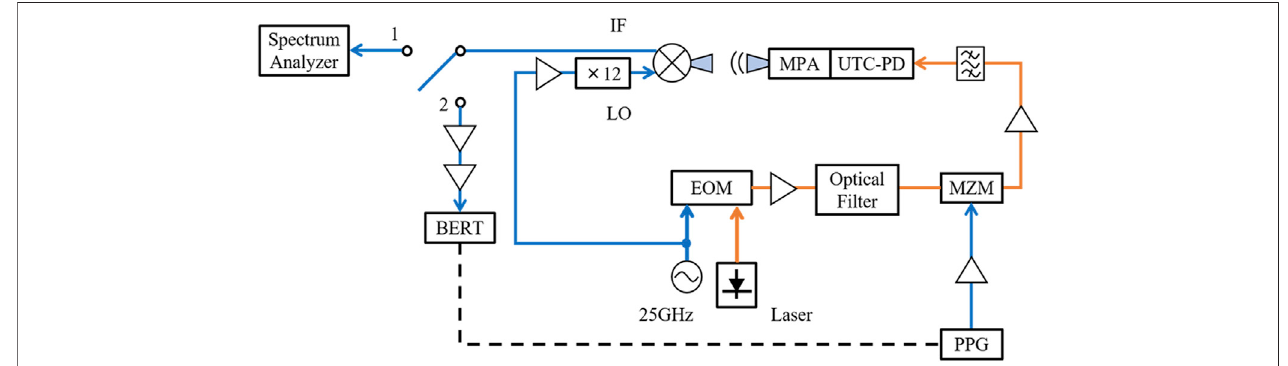
FIGURE 6 | Experimental setup for the transmission experiment. EOM: electro-optic modulator, MZM, Mach – Zehnder modulator; UTC-PD, unitraveling -carrier photodiode; MPA, medium-power ampli fi er; BERT, bit-error-rate tester; PPG, pulse-pattern generator.